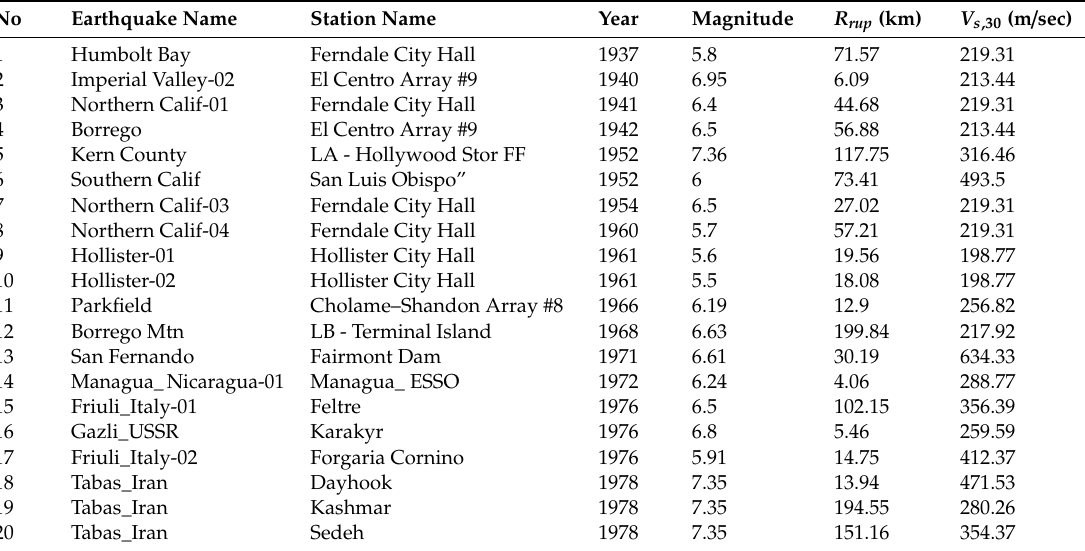
Table 5. Details of the selected earthquake ground motion.